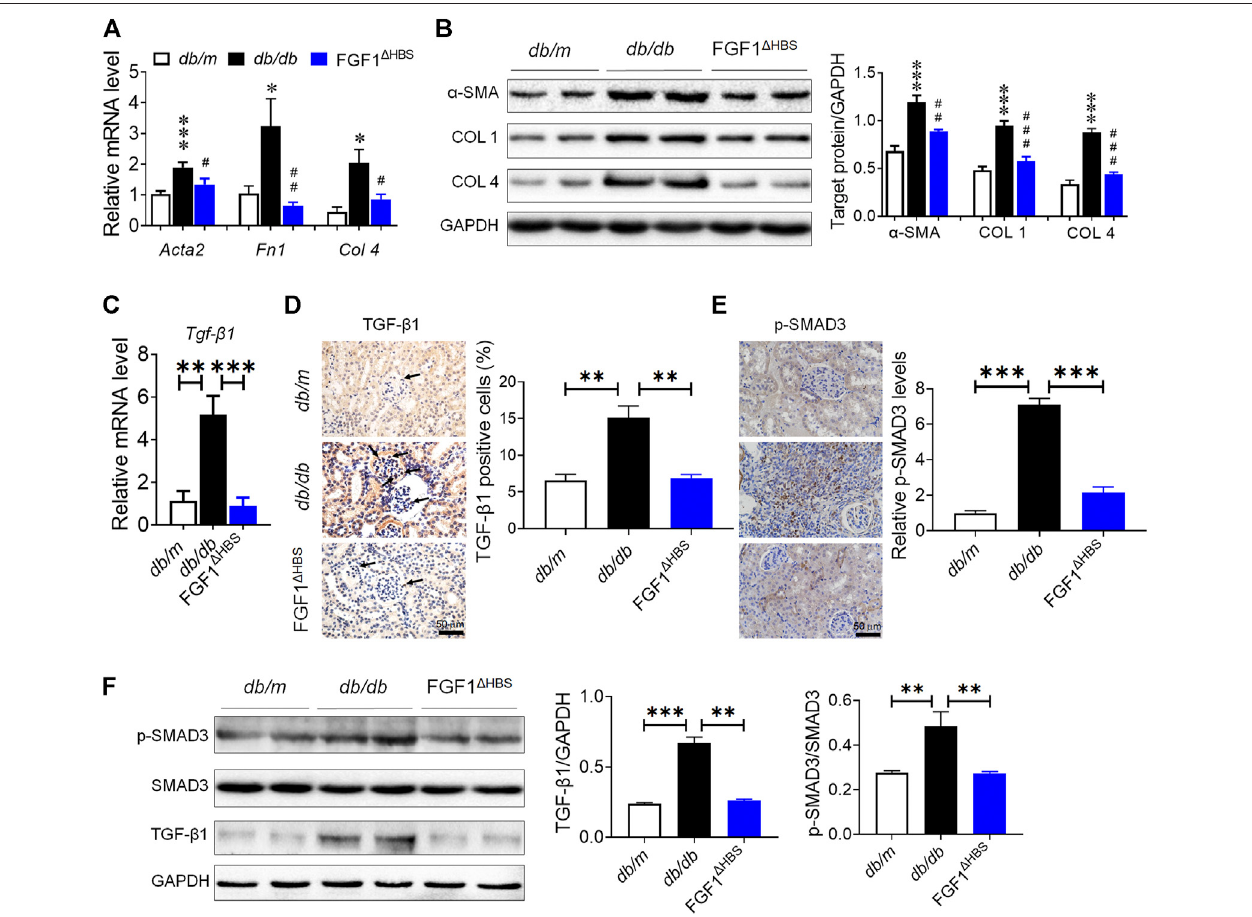
FIGURE 2 | FGF1 Δ HBS suppressed renal fi brosis and TGF- β 1 signaling in d b/ d b mice. (A) Real-time PCR analysis of Acta2 , Fn1 , and Col 4 mRNA expression. (B) Expression levels of α -SMA, COL 1, and COL 4 as determined by western blot analysis and quantitation using ImageJ. (C) Real-time PCR analysis of TGF- β 1 mRNA expression levels. (D) Representative images of TGF- β 1 immunohistochemical staining of renal tissues and quantitation using ImageJ. ( E ) Representative images of phosphorylated SMAD3 immunohistochemical staining of renal tissues and quantitation using ImageJ. (F) Expression levels of phosphorylated SMAD3, SMAD3, and TGF- β 1 as determined by western blot analysis and quantitation using ImageJ. Data are presented as the mean ± SEM ( n (cid:1) 6); Panels A and B, * p < 0.05, *** p < 0.001 vs. d b/m ; # p < 0.05, ## p < 0.01, ### p < 0.001 vs. d b /d b ; Panels C – F, ** p < 0.01, *** p < 0.001.